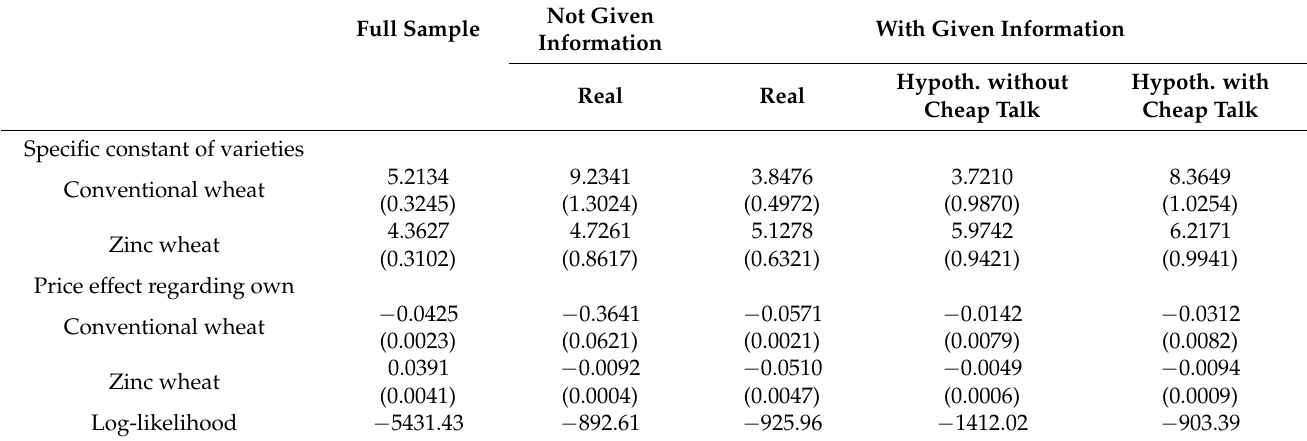
Table 4. Estimation of parameter—bivariate probit